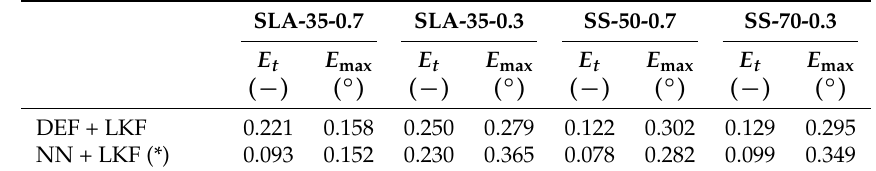
Table 4. Norm and maximum errors for roll angle estimators for sine sweep and slalom